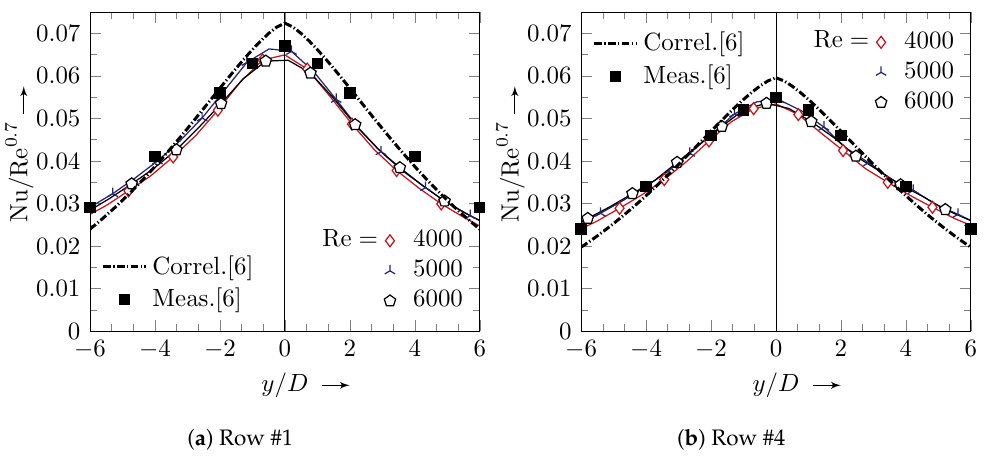
Figure 11. Comparison of the heat transfer characteristics with literature data.